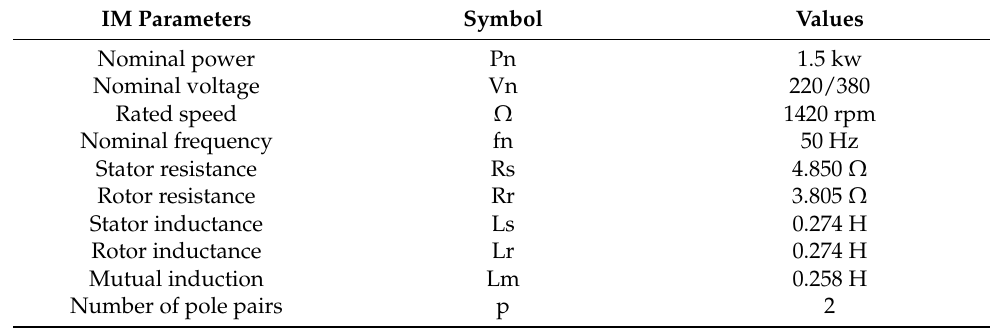
Table A3. Parameters of the induction